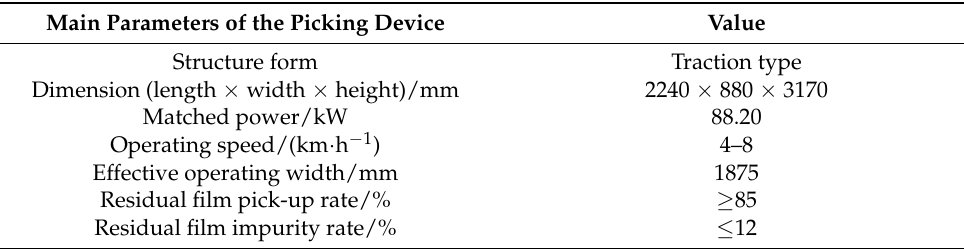
Table 1. The main working parameters of a picking device. Main Parameters of the Picking Device